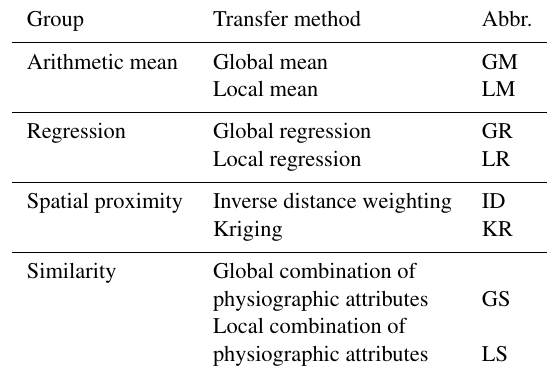
Table 1. The list of model parameter transfer methods tested in the study. Group